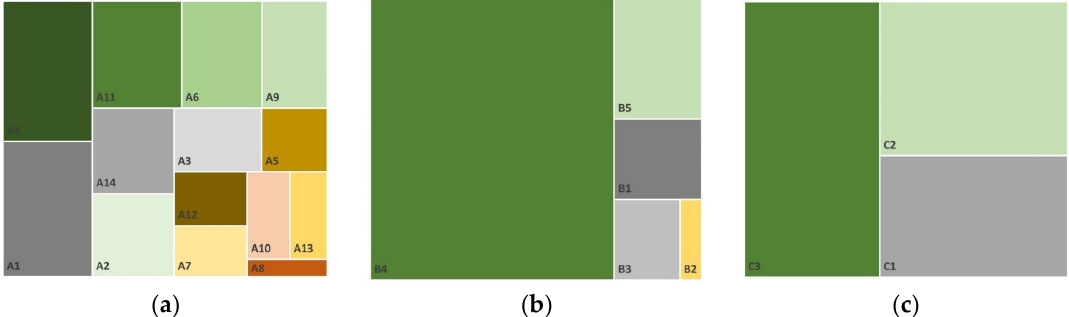
Figure 8. Classification and number of published articles according to ( a ) variables; ( b ) sampling frequency; and ( c ) period analyzed.